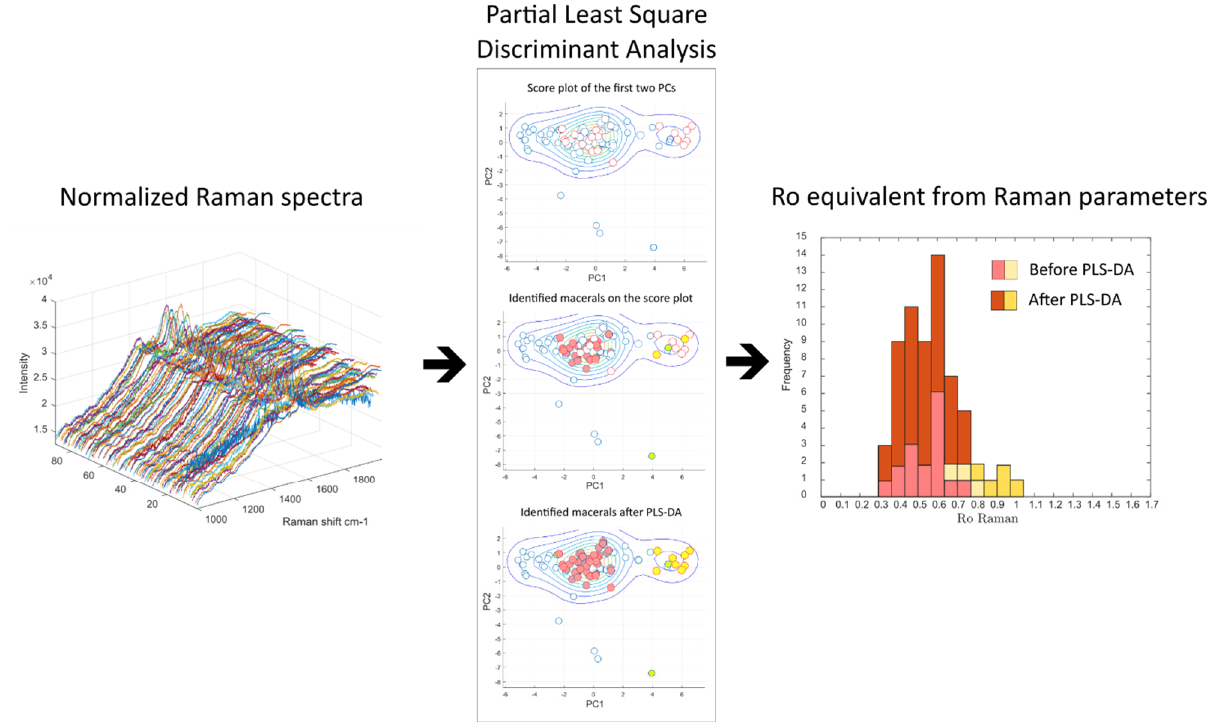
Figure 2. Workflow of the supervised classification used to identify vitrinite spectra. Original spectra have been plotted after PCA analysis on a score plot where identified macerals (vitrinite and inertinite) have been put in evidence before and after PLS-DA analysis (red dots for vitrinite and yellow dots for inertinite). Frequency histogram to the right shows reflectance equivalent values calculated before and after PLS-DA on different macerals (red bins for vitrinite, yellow bins for inertinite).